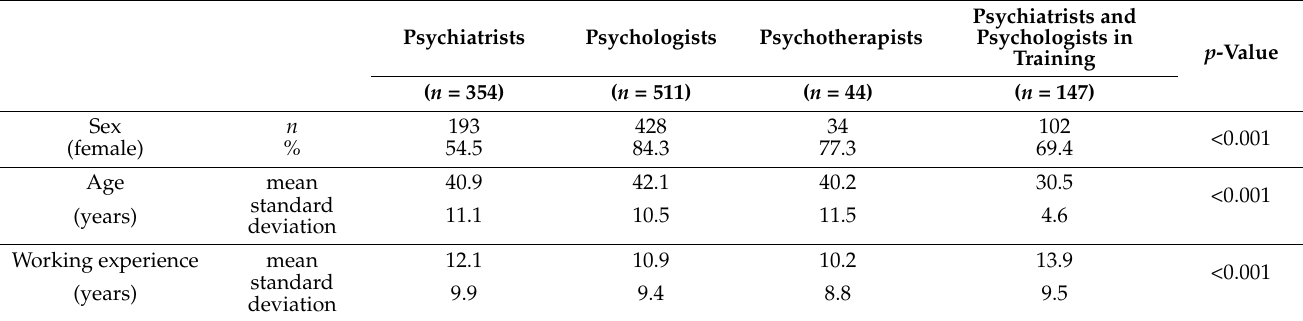
Table 2. Main characteristics of participants according to their profession.